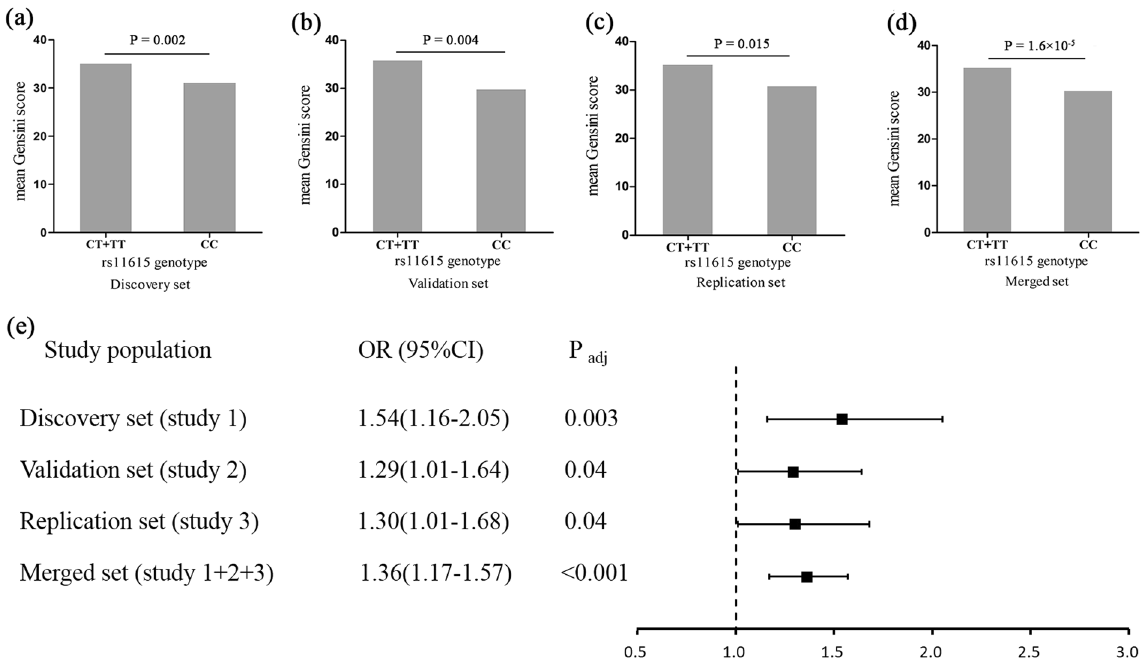
Figure 2. Genetic estimates of association of SNP rs11615 with Gensini score. Variant genotypes (CT + TT) of SNP rs11615 was associated with higher Gensini score (median) in the discovery set ( a ), validation set ( b ), replication set ( c ) and the merged set ( d ) and also associated with increased risk of severity of coronary artery atherosclerosis in independent or merged set ( e ). P, non-adjusted P; P adj , adjusted